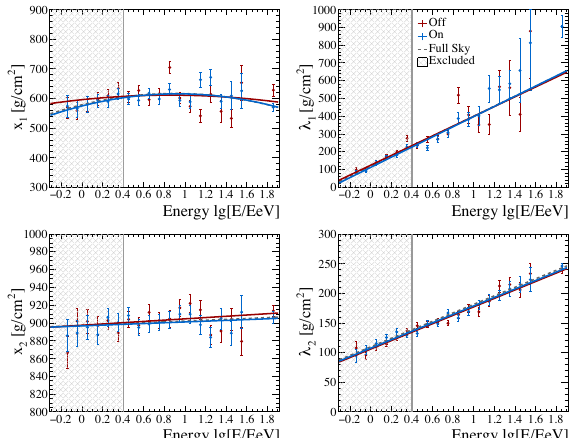
Figure 3: The X max acceptance parameterizations for the on- and o ↵ -plane sky regions from Monte Carlo.